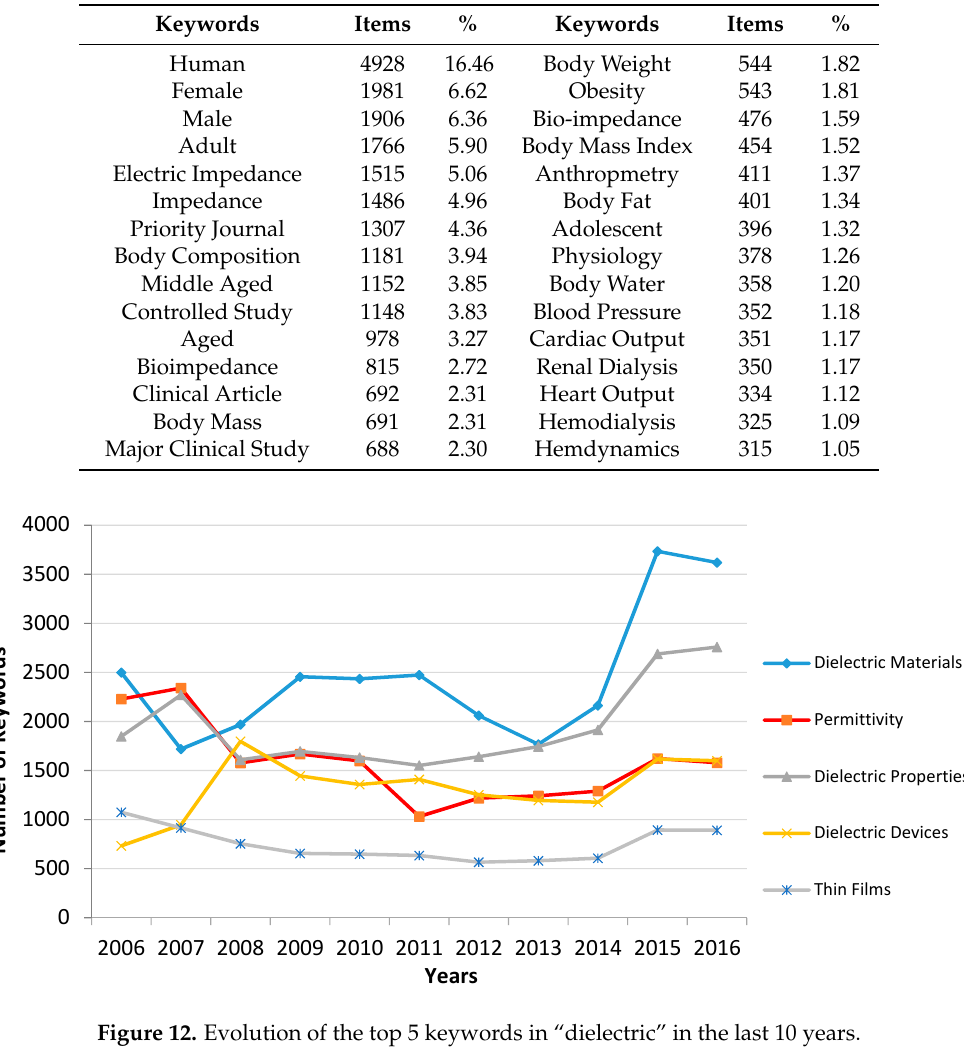
Table 4. Top 30 keywords used in bioimpedance.